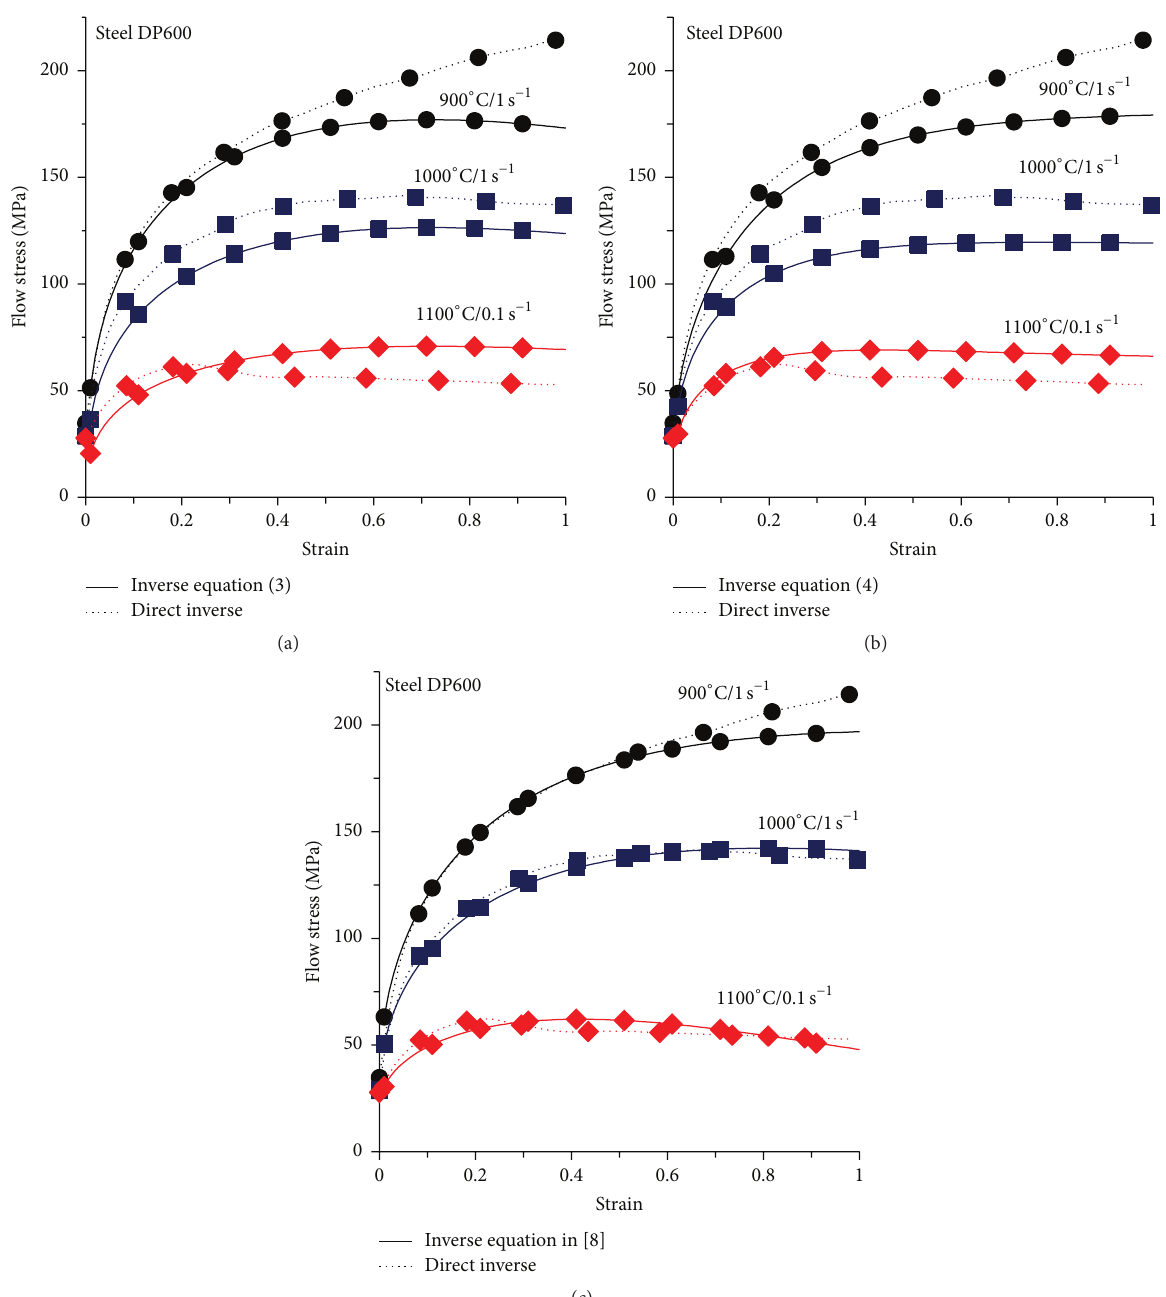
Figure 11: Comparison between the result of the direct inverse analysis (dotted lines) and the plots of functions with coefficients in Table 6 (solid lines): (a) function (3); (b) function (4); (c) model of